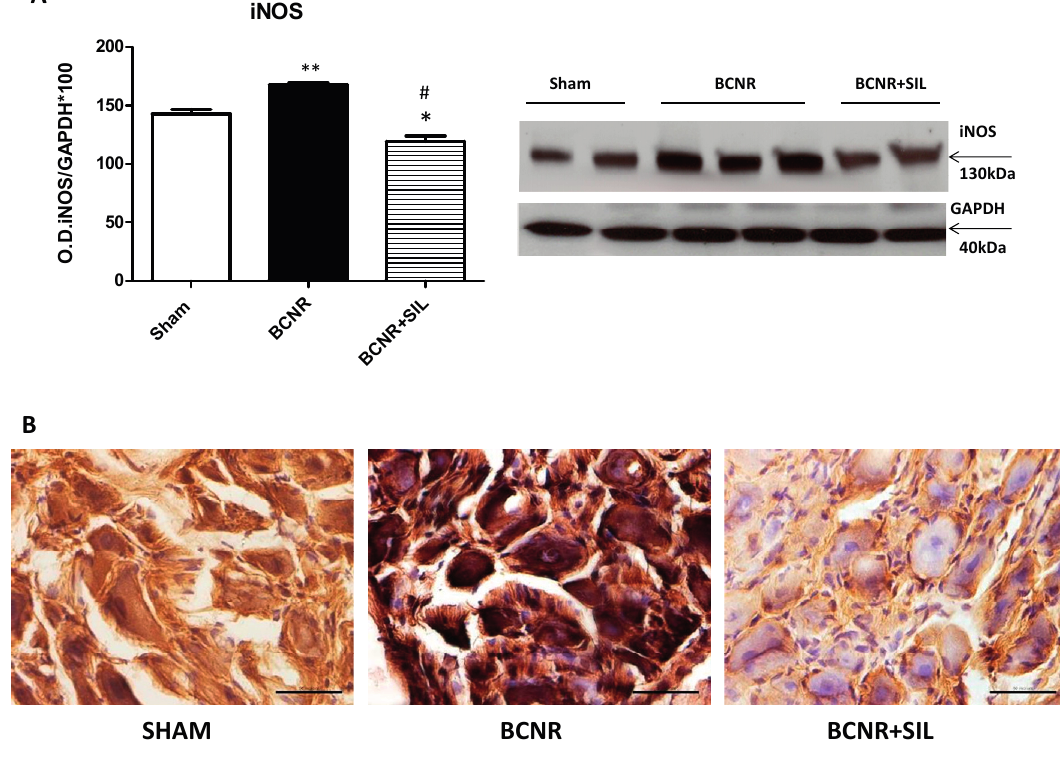
Figure 4. Inducible nitric oxide synthase (iNOS) expression is down regulated by Sildenafil treatment after BCNR. ( A ) Total protein extracts of Sham, BCNR and BCNR + SIL were subjected to Western blot studies for iNOS and normalized by GAPDH with the correspondent densitometric analysis, * p < 0.05, ** p < 0.01, respect to sham. # p < 0.05 respect to BCNR; ( B ) Frozen section of the pelvic ganglia were immunostained with a polyclonal antibody against iNOS followed by a biotinylated secondary antibody and Vectastain ®